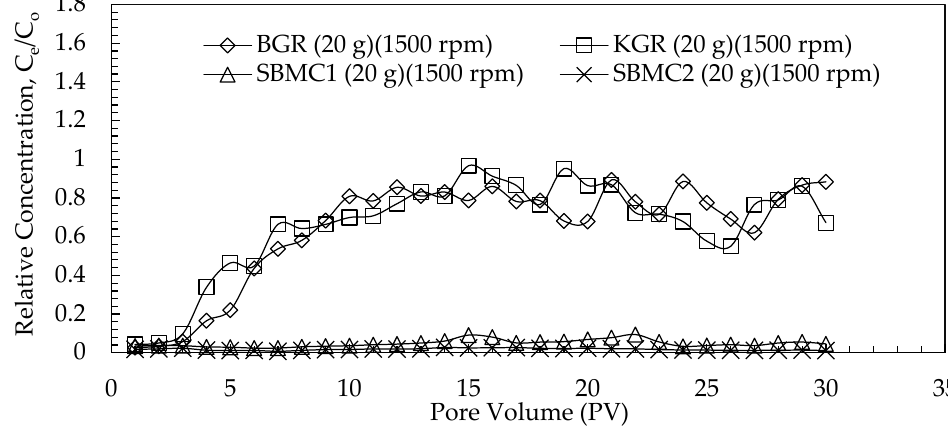
Figure 6. Breakthrough curves for granite soil (BGR, KGR) and marine clay (SBMC).